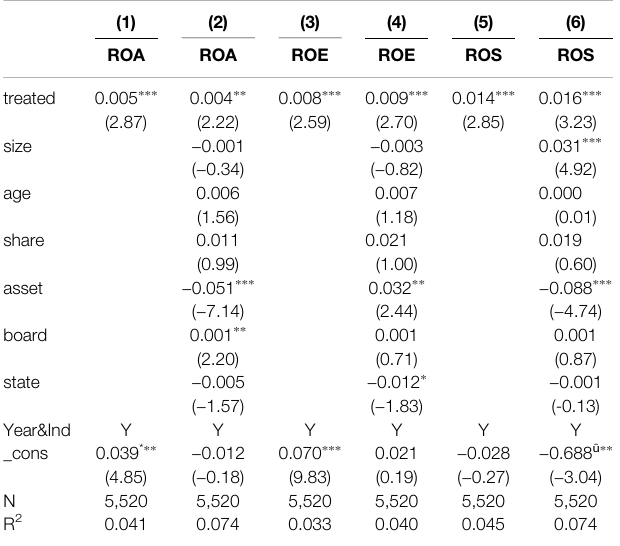
TABLE 4 | New Environmental Protection Law and enterprise